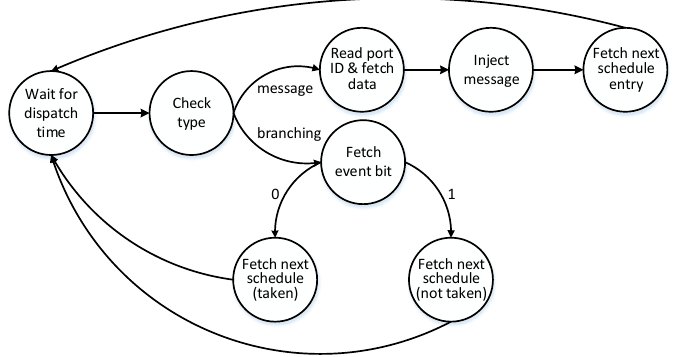
Figure 10. Adaptation state machine.